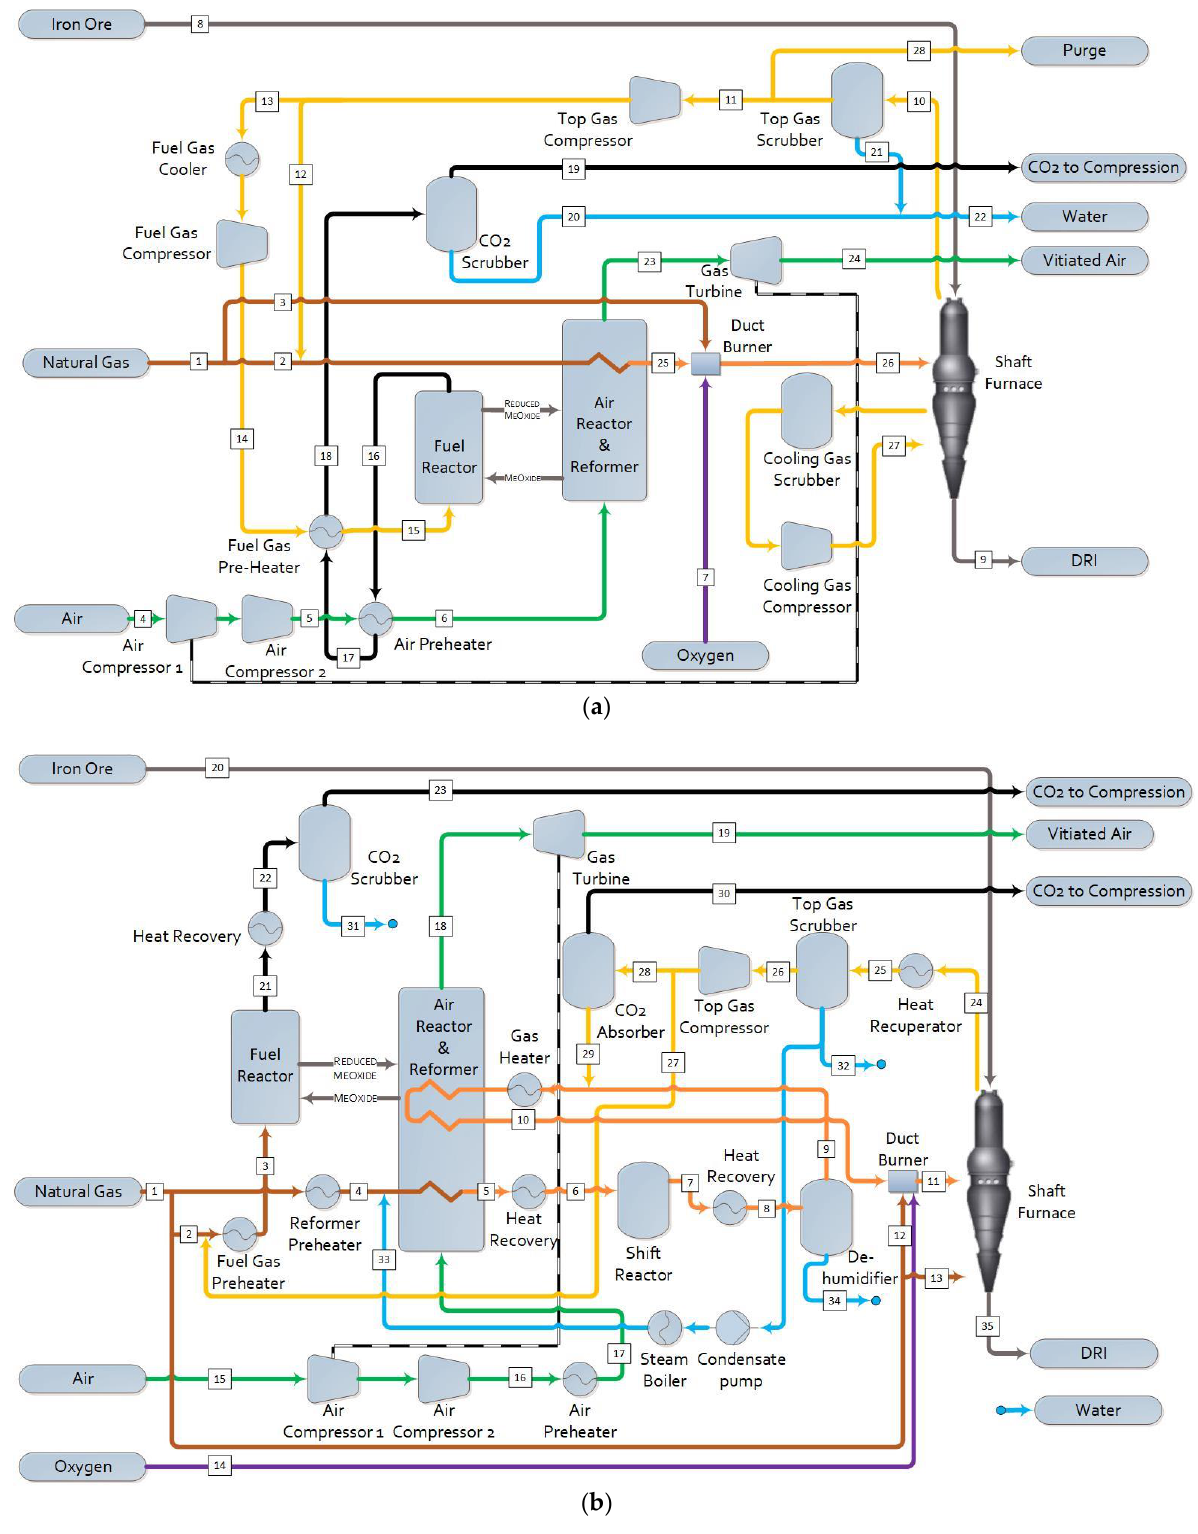
Figure 2. Simplified process configurations for PCL-DRI processes following: ( a ) a Midrex-type flowsheet (PCL-DRI—M) and ( b ) an Energiron III-type flowsheet (PCL-DRI—E). For ease of view- ing, not all heat exchangers or heat integration are shown. Stream properties are defined in the Supplementary Materials (Tables S3 and